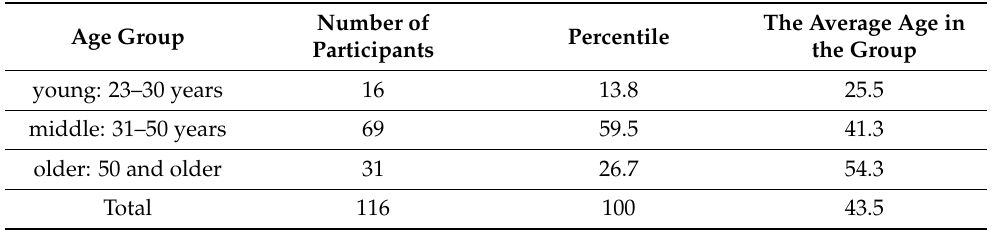
Table 1. Number of participants according to their age.